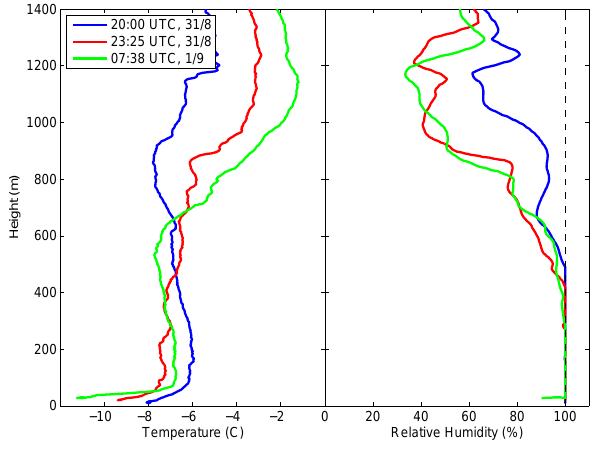
at 21:21UTC (87 ◦ N), at the onset of the event shown in Figure 3, Fig. 5. A rare case of a double fog bow observed on August 31 at 21:21 UTC (87 ◦ N), at the onset of the event Fig. 4. Profiles of temperature and relative humidity with respect to reveals the presence of large cloud droplets in the 20–50µm size shown in Figure 3, reveals the presence of large cloud droplets in the 20-50 µ m size range. The fog, or cloud, is liquid corresponding to the case shown in Fig. 3. range. The fog, or cloud, is also visible towards the horizon where Fig. 4. Profiles of temperature and relative humidity with respect to liquid corresponding to the case shown in the optical thickness along the line of sight becomes increasingly also visible towards the horizon where the optical thickness along the line of sight becomes increasingly large, Figure 3. large, or simply reflecting horizontal or simply reflecting horizontal inhomogeneities.